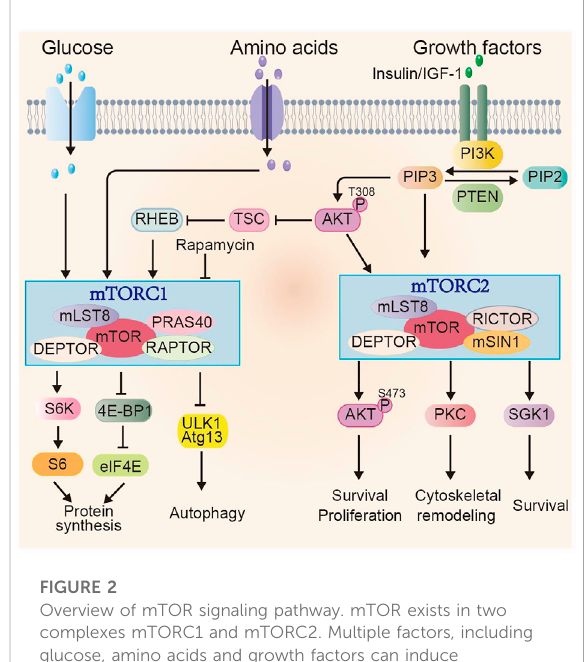
FIGURE 2 Overview of mTOR signaling pathway. mTOR exists in two complexes mTORC1 and mTORC2. Multiple factors, including glucose, amino acids and growth factors can induce mTORC1 activity through various signaling cascades. Activated mTORC1 promotes anabolic processes, e.g., protein synthesis through phosphorylating its downstream effectors, such as S6K and 4E-BP1 and inhibits catabolic process, such as autophagy. The regulation of mTORC2 activity is mainly through growth factors and PI3K signaling. The activated mTORC2 signaling regulates cell survival, proliferation and cytoskeletalre-organizationthroughphosphorylatingmembersof AGC family, including AKT (at Ser473), PKC and